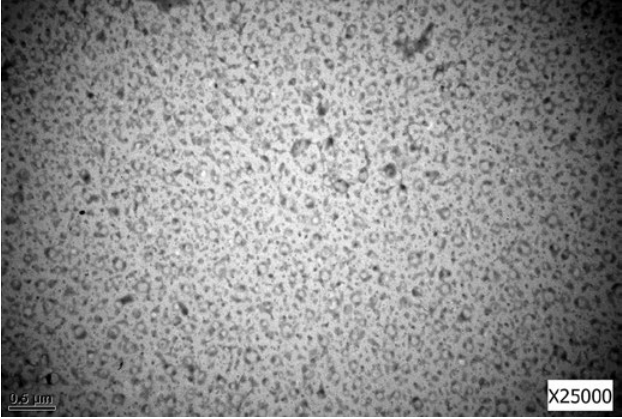
FIGURE 2 - TEM image of